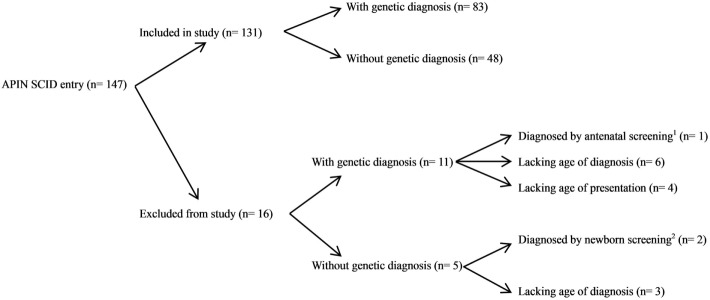
Patients selection algorithm in this study. From 147 SCID entries in the Asian Primary Immunodeficiency Network (APIN) database, 131 patients were included in our study and 16 patients were excluded from our study. Three patients were excluded as they were diagnosed by screening either antenatally or at birth. Thirteen patients were excluded due to the lack of age at presentation (n = 4) or the lack of age at diagnosis (n = 9). 1Cordocentesis was performed due to positive family history of SCID, revealed low CD4+ count. 2Complete blood count, lymphocyte subsets, and immunoglobulins measurement were performed in one patient due to positive family history, revealed severe T- and B-cell lymphopenia and low serum IgA and IgM; newborn T-cell receptor excision circle (TREC) screening revealed 0 TREC copy in another patient.